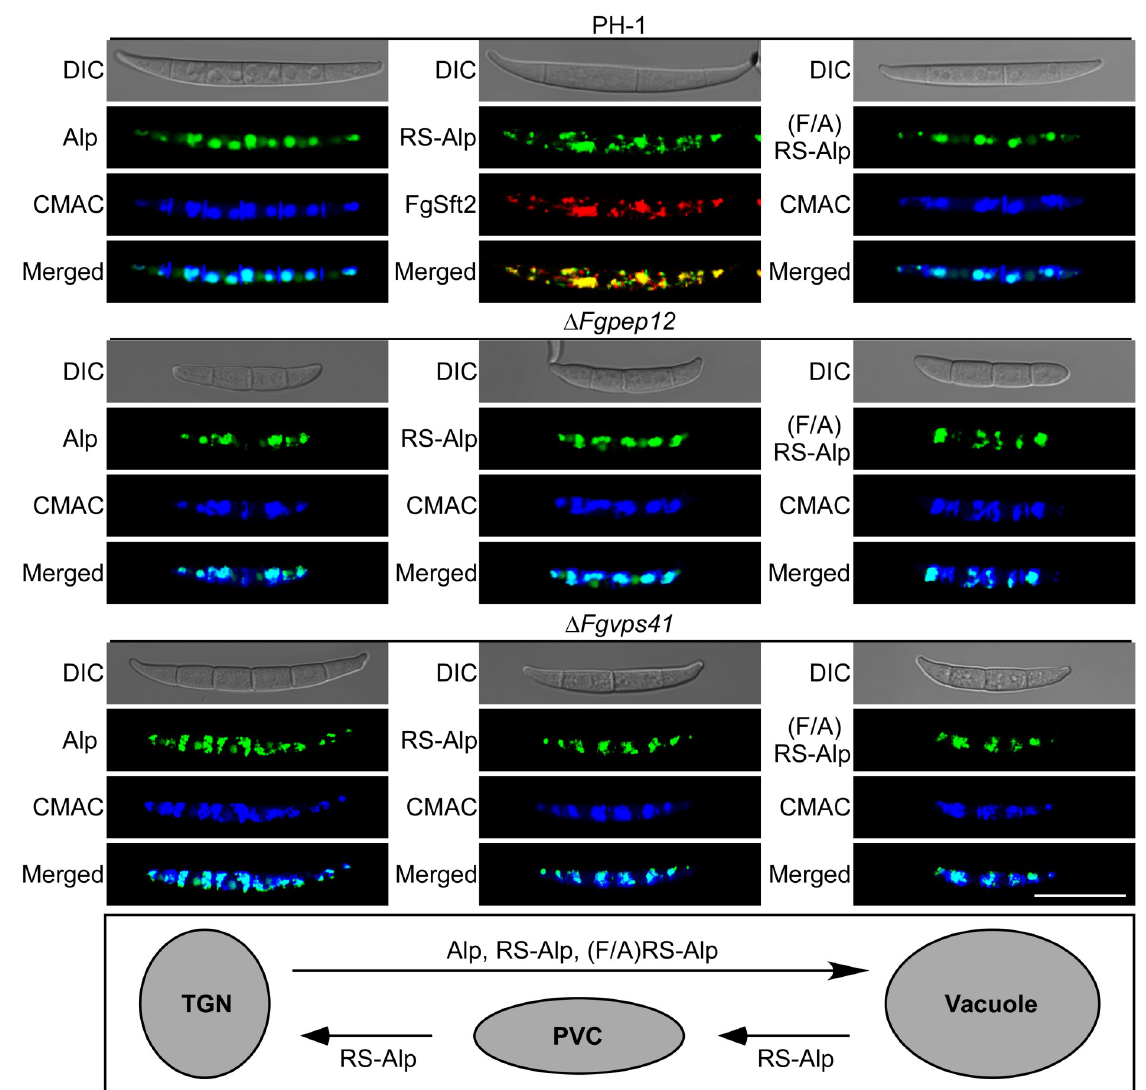
Fig 5. FgPep12 is required for retrograde transport of RS-Alp from the vacuole to the PVC. Conidia of transformants expressing Alp- GFP, RS-Alp-GFP and (F/A)RS-Alp-GFP in the wild type PH-1, Δ Fgpep12 and Δ Fgvps41 mutants were examined by DIC or fluorescence microscope. CMAC staining or expressing RFP-FgSft2 was performed to co-localize with target proteins. Bar = 10 μ m.